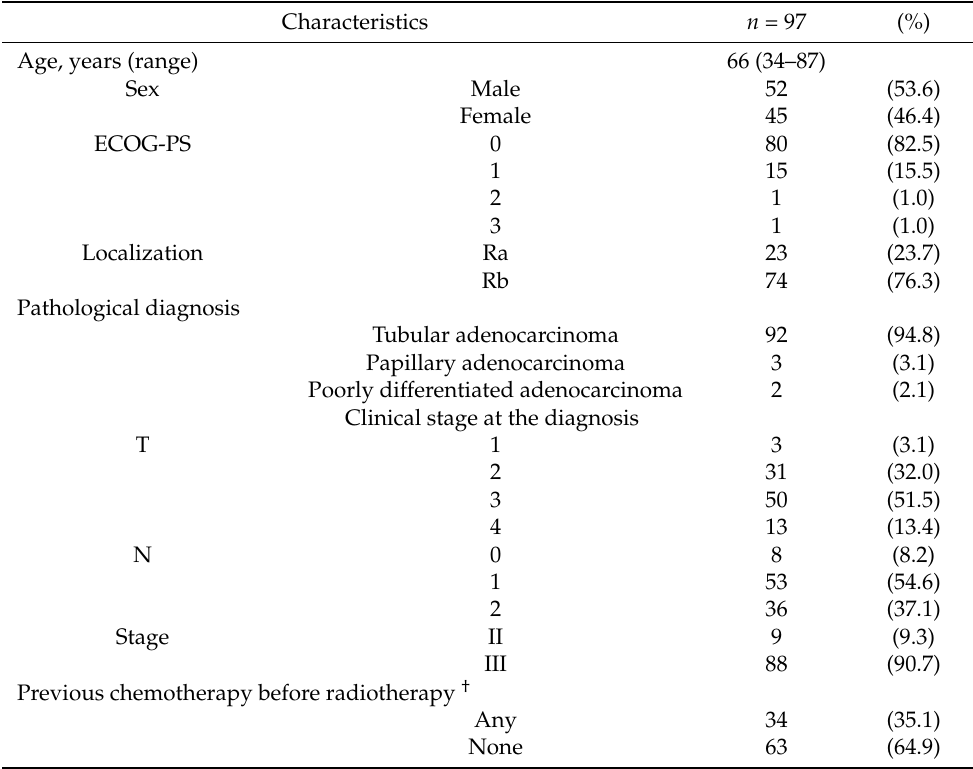
Table 1. Patient